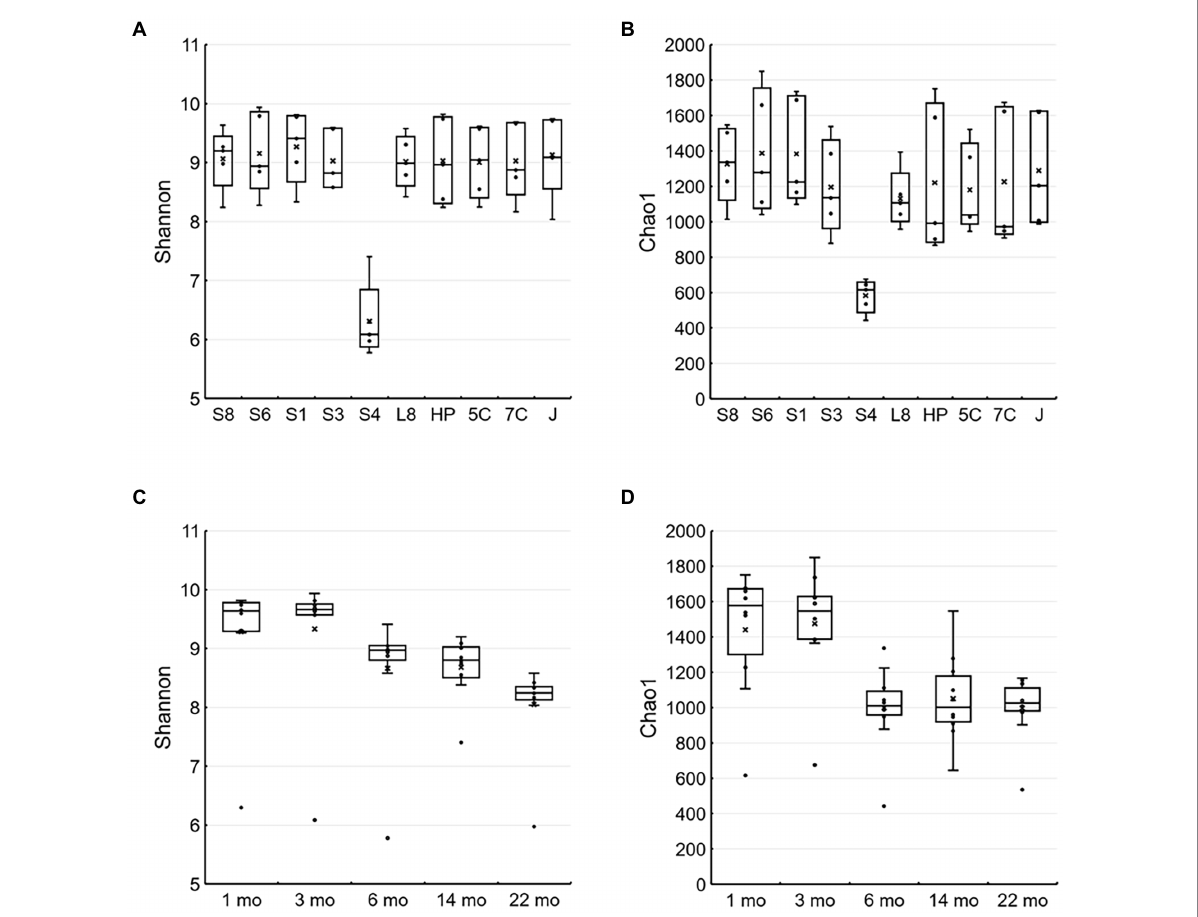
FIGURE 5 Alpha diversity of microbial communities in each environment and metal. The Shannon (A,C) and Chao1 (B,D) indices are represented as box-and- whisker plots. (A) and (C) were calculated based on each type of stainless steel ( n = 5), and (B) and (D) were calculated based on time of each sampling ( n = 10). The line in the middle of the box, top, and bottom of the box, whiskers, and cross symbols represent the median, 25 and 75 percentiles, min-to-max values, and average, respectively. S8, S30400; S6, S31600; S1, Casting S31600; S3, S30300; S4, S40300; L8, S42000; HP, S41426; 5C, 15% Cr; 7C, 17% Cr; and J,